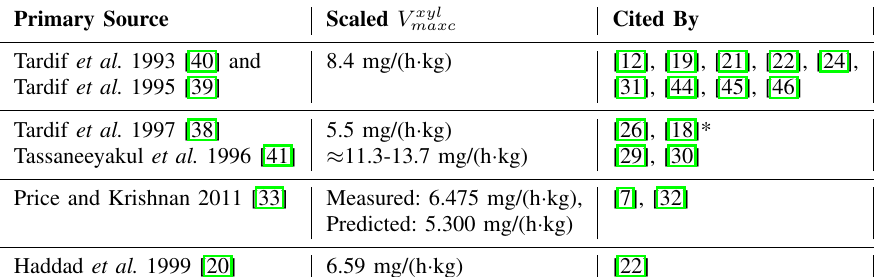
T ABLE OF VARIOUS VALUES OF V xyl maxc VALUES AND REFERENCES CITING THEM . N UMERICAL VALUES HAVE BEEN RESCALED FOR CONSISTENCY . L ISTED SOURCES EITHER USED THE VALUE GIVEN ( NOT NECESSARILY SCALED ) OR USED THE DATA FROM THE PAPER IN SOME WAY . N OTE THAT THE REFERENCE MARKED (*) CITED THE GIVEN SOURCE